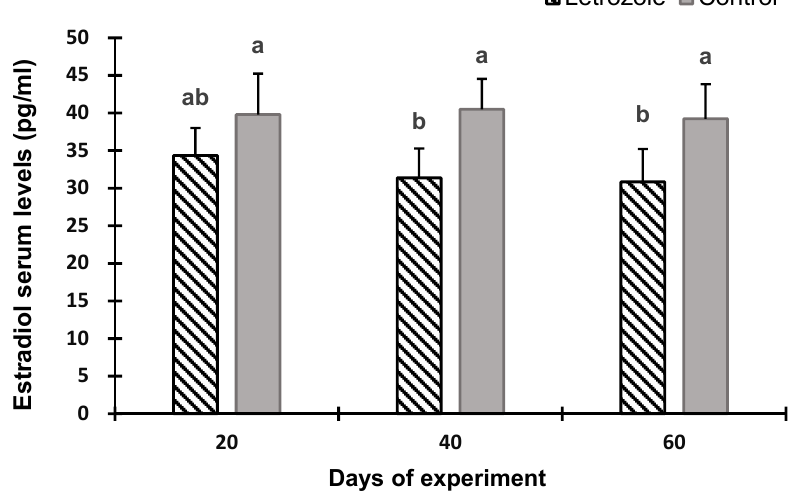
Figure 2. Estradiol levels in Markhoz bucks treated letrozole (0.25 mg/kg BW/wk) or control. Error bars indicate standard deviation. a,b Statistically significant differences (p<0.05) between the groups.